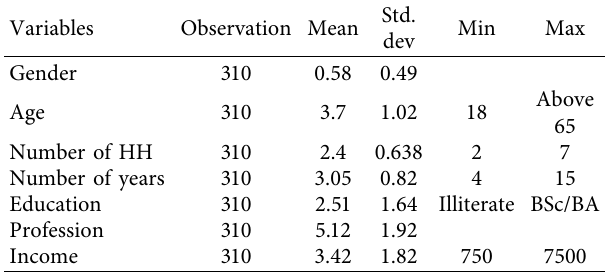
Table 2: General information of respondents.